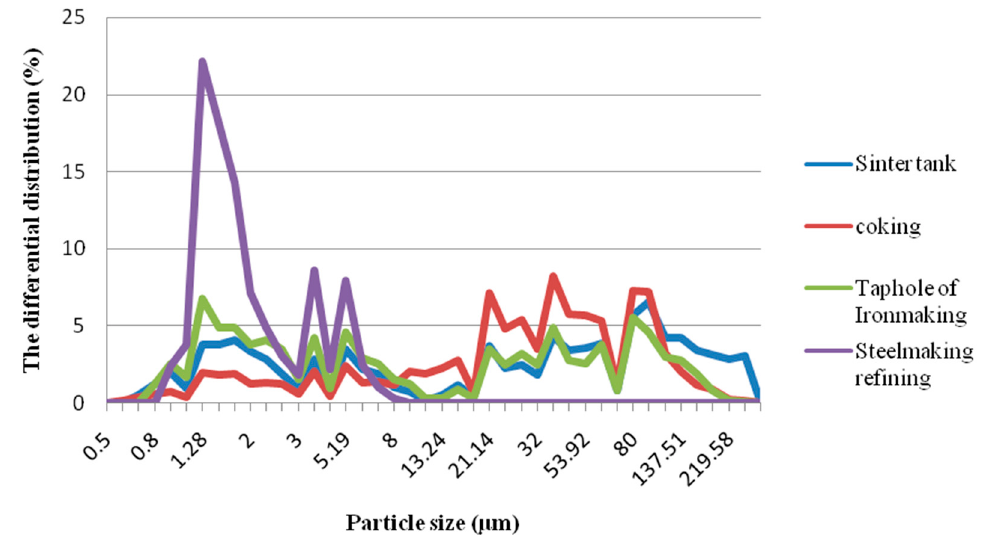
Figure 1. Distribution of particle size in different production processes.